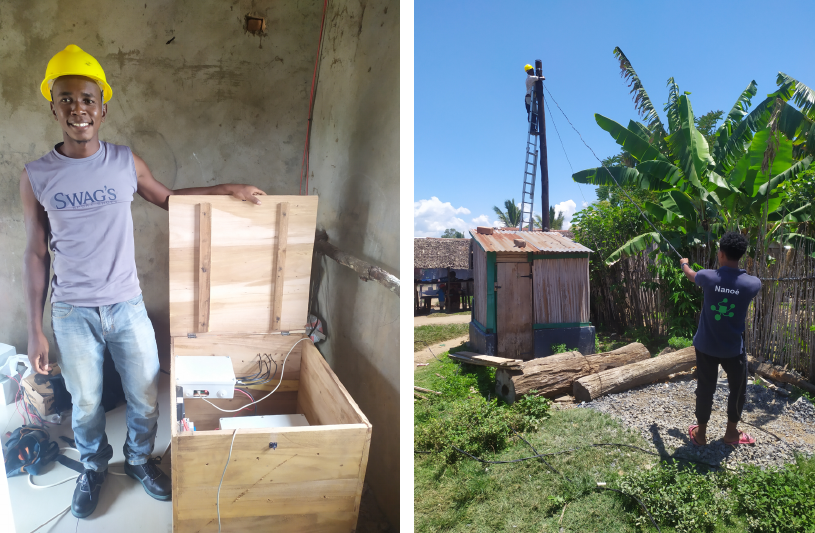
Figure 28. Installation of the interconnection modules in Ambohimena and cable connection at the top of a pole.